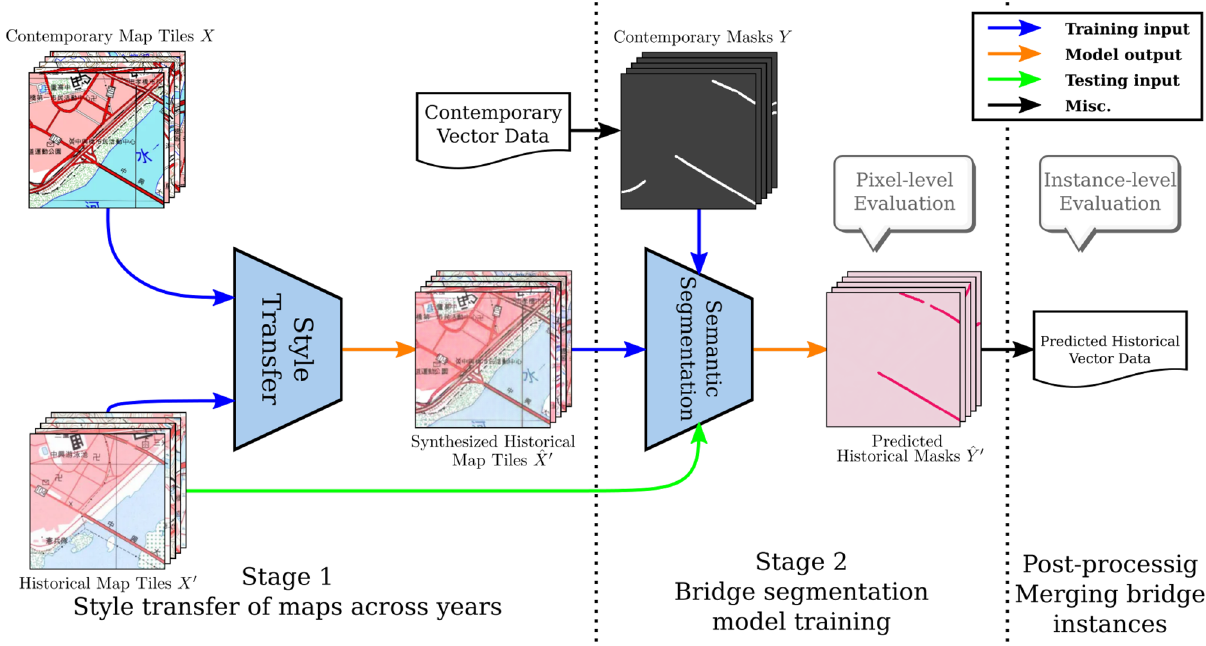
Figure 1. The proposed two-stage framework for cross-year historical map analysis based on semi-supervised learning of map style transfer and bridge segmentation. † The maps in this figure are provided by Taiwan Historical Maps System (https:// gis. sinica. edu. tw/ tiles erver/) with